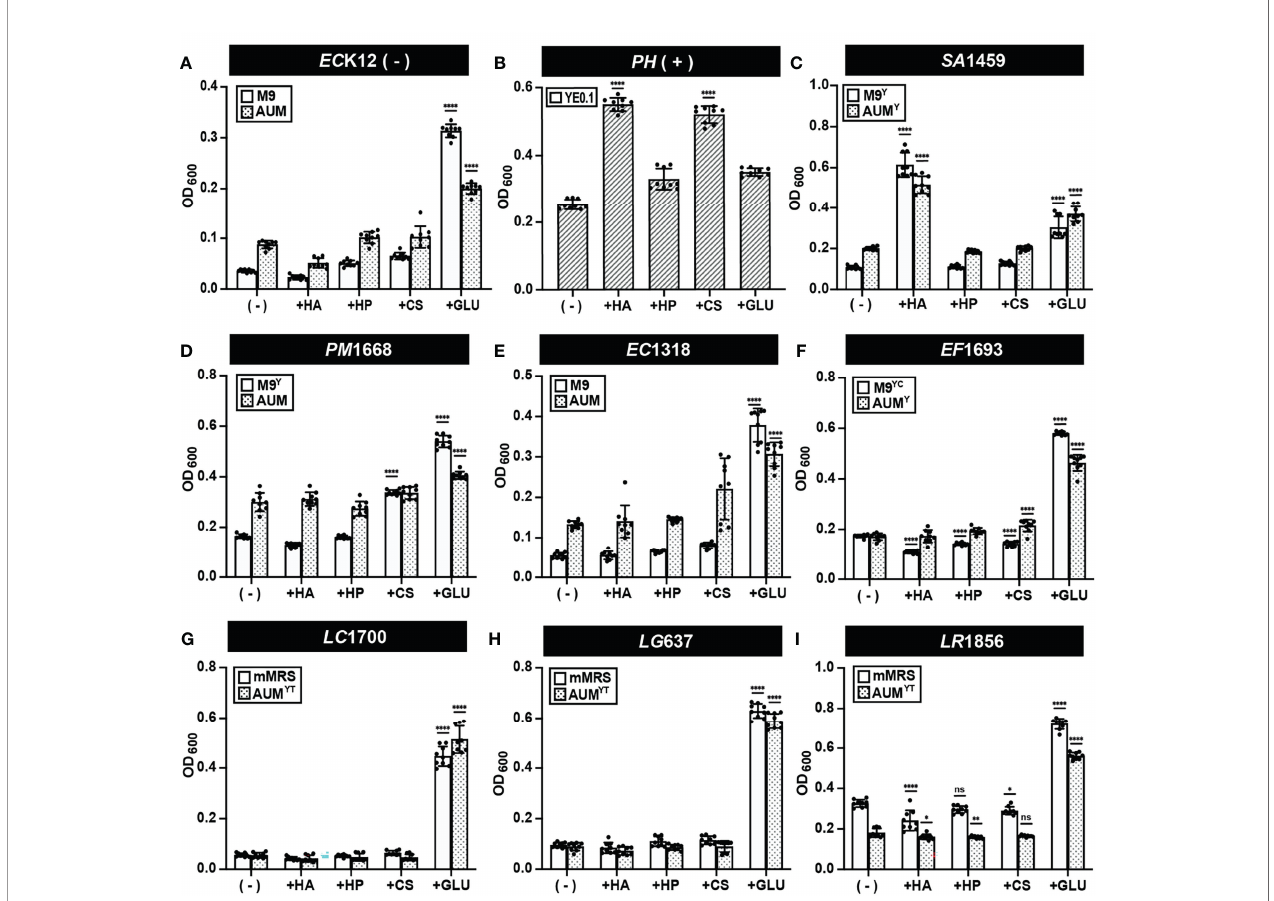
FIGURE 5 | GAG growth assays (Endpoint OD600) of representative strains. Bacterial strains (A) E. coli K12 (B) P. heparinus (C) S. agalactiae SA1459 (D) P. mirabilis PM1668 (E) E. coli EC1318 (F) E. faecalis EF1693 (G) L. crispatus LC1700 (H) L. gasseri LG637 (I) L. rhamnosus LR1856 were cultured in basal or AUM media and supplemented with HA, HP, CS, or glucose and endpoint OD 600 was measured to assess GAG utilization activity. Assays were performed in three biological replicates and three technical replicates. An ordinary one-way ANOVA with Dunnett ’ s Multiple Comparisons Test was performed to compare basal/AUM media alone (-) and in the presence of GAGs or glucose and statistically signi fi cant values 1.5 times above baseline are shown. Dots represent values across three biological replicates and three technical replicates and error bars represent standard deviation (* p < 0.05, ** p < 0.01, **** p < 0.0001, ns, not signi fi